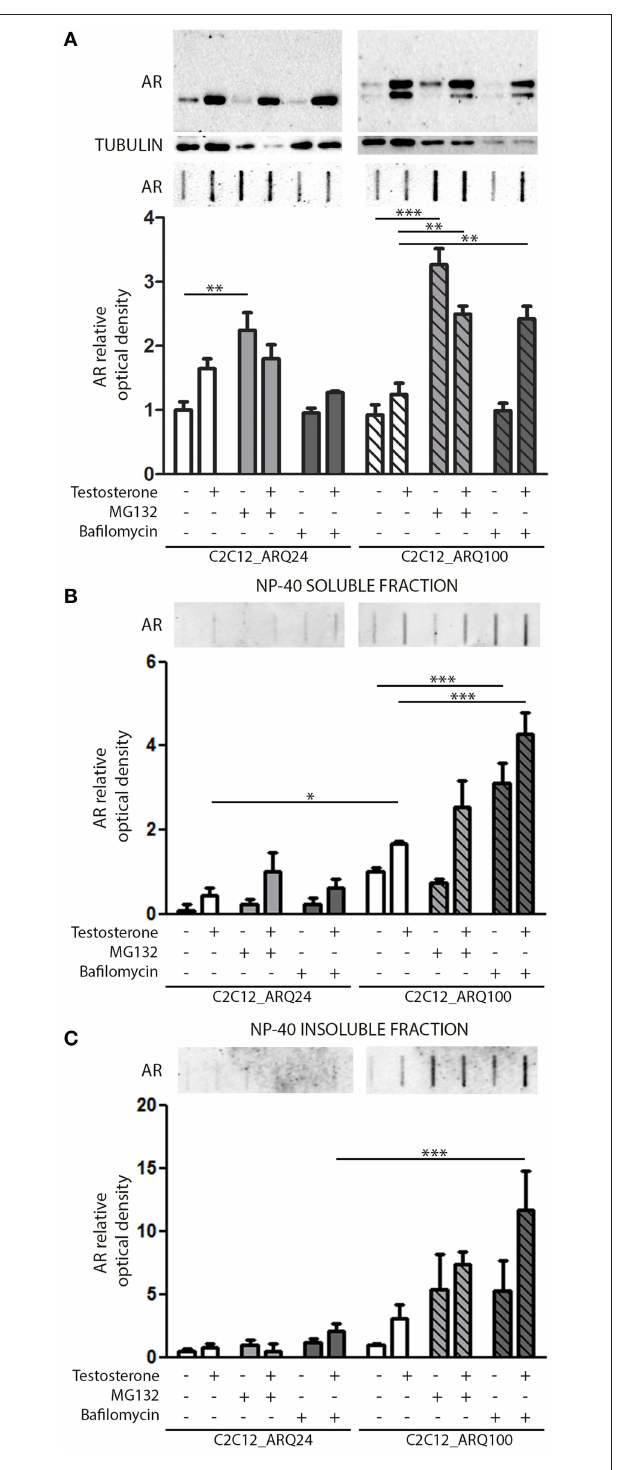
FIGURE 2 | Degradative systems involvement. (A) WB (upper inset) and FRA (middle inset) of PBS extract of cells treated with testosterone, MG132 and bafilomycin A1. Optical densitometry quantification of FRA (lower inset). (** p < 0.01; *** p < 0.001 vs. relative control conditions –T/ + T). (B) FRA (upper inset) of NP-40 soluble extracts of cells treated with testosterone, MG132 and